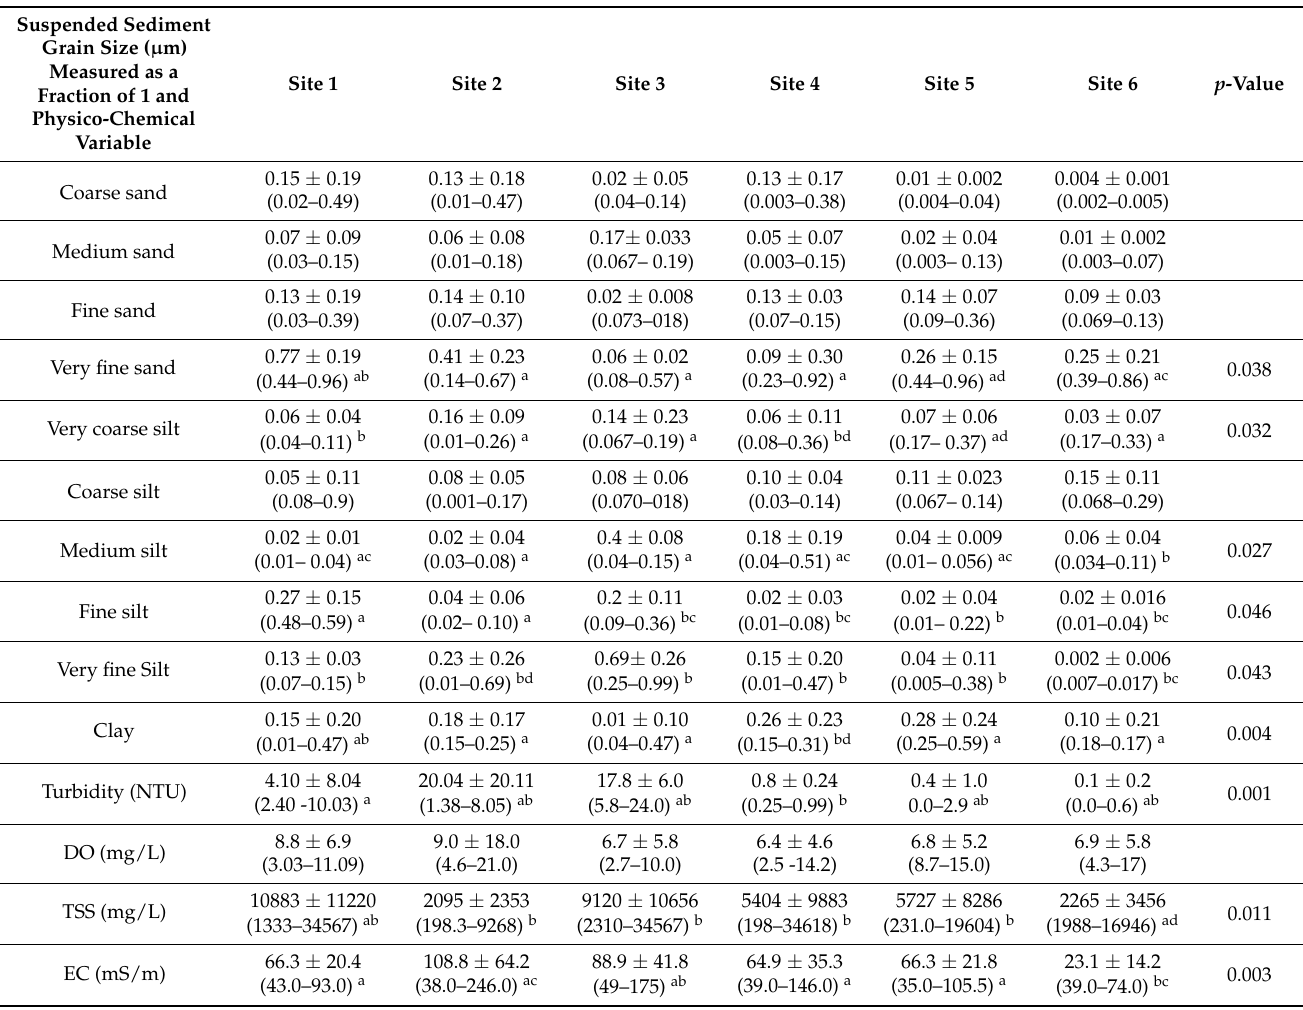
Table 2. Means, ± standard deviations, and ranges (in parentheses) for the volumetric distribution of suspended fine sediment grain sizes and physico-chemical variables across sites in the Tsitsa River and its tributaries. Different superscript letters for very fine sand, very coarse silt, medium silt, fine silt, and total suspended solids across sites that indicate significant differences ( p < 0.05) revealed by Tukey HSD post-hoc test. The same superscript letter between sites per variable indicates no significant differences ( p > 0.05). The sediment grain sizes are reported a volumetric fraction of 1.